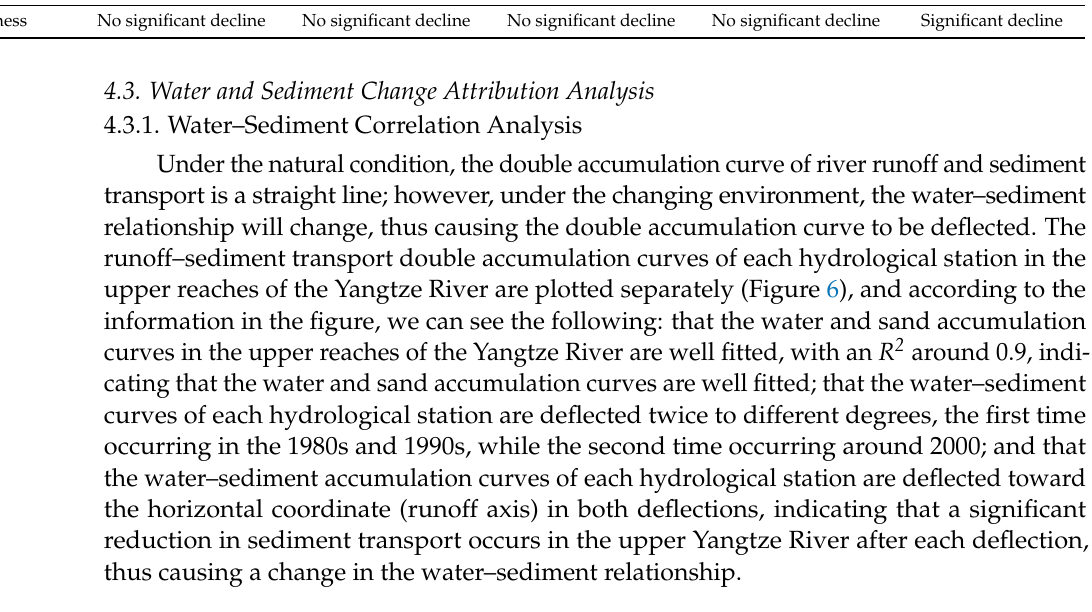
Table 4. TFPW–MK trend test of SI values in the upper reaches of the Yangtze